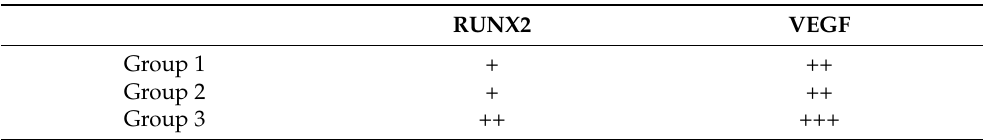
Table 2. Immunohistochemical outcomes for RUNX2 and VEGF of the three groups after 6 months of bone repair. RUNX2 VEGF Group 1 + ++ Group 2 + ++ Group 3 ++